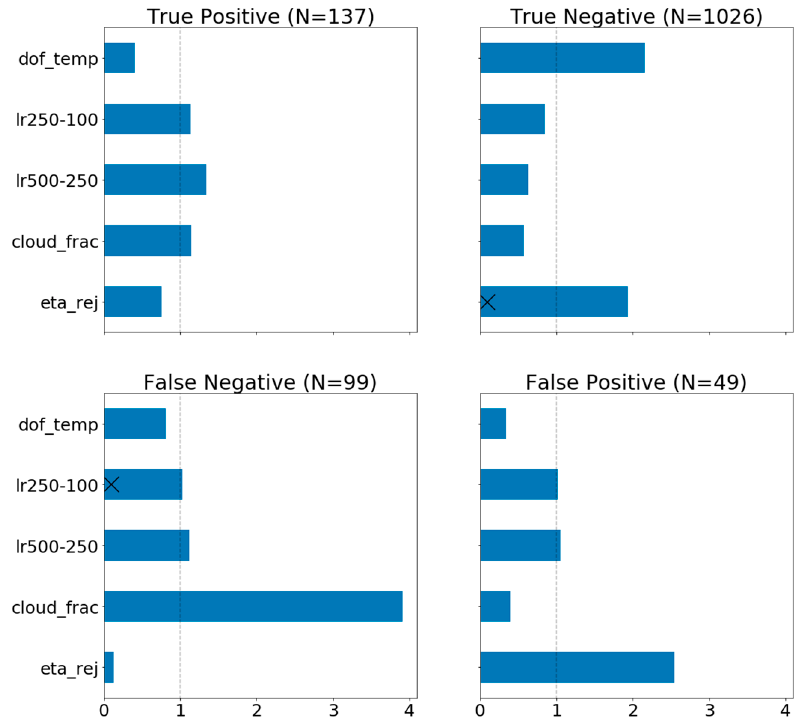
Figure 6. Results for a logistic regression on diagnostic parameters for the four CAA detection states described in Table 1. X indicates diagnostic parameters that do not meet statistical significance requirements.